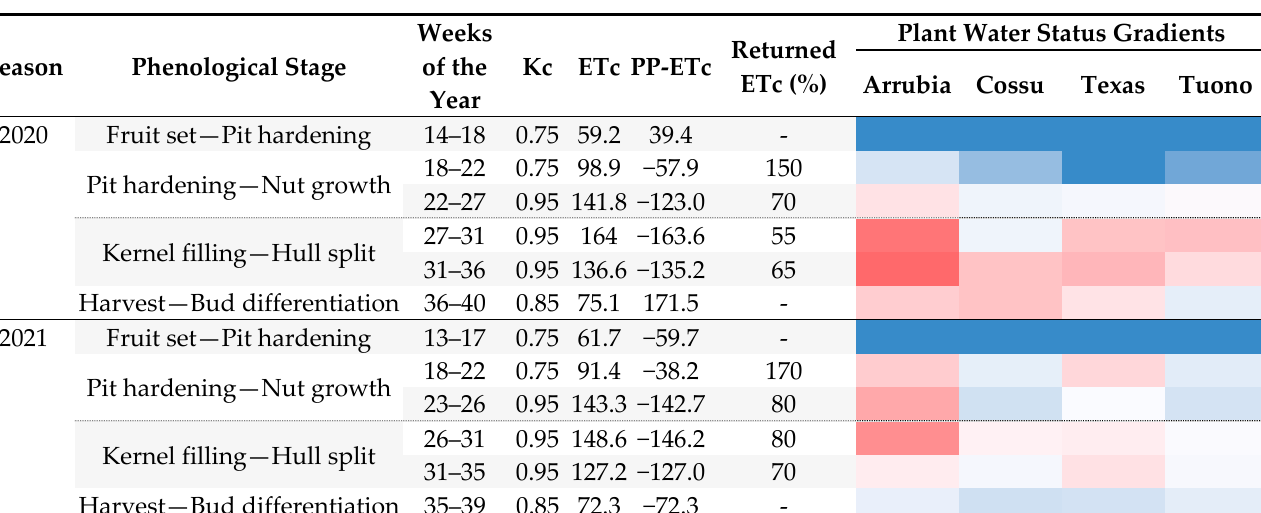
Table 3. Orchard water balance, deficit irrigation strategy, and midday plant water status comparison among four cultivar during the growing seasons. The gradients of increasing plant water stress in the four cultivar are represented by the gradients of color intensity, respectively, from dark blue to light blue, and to light and dark red.